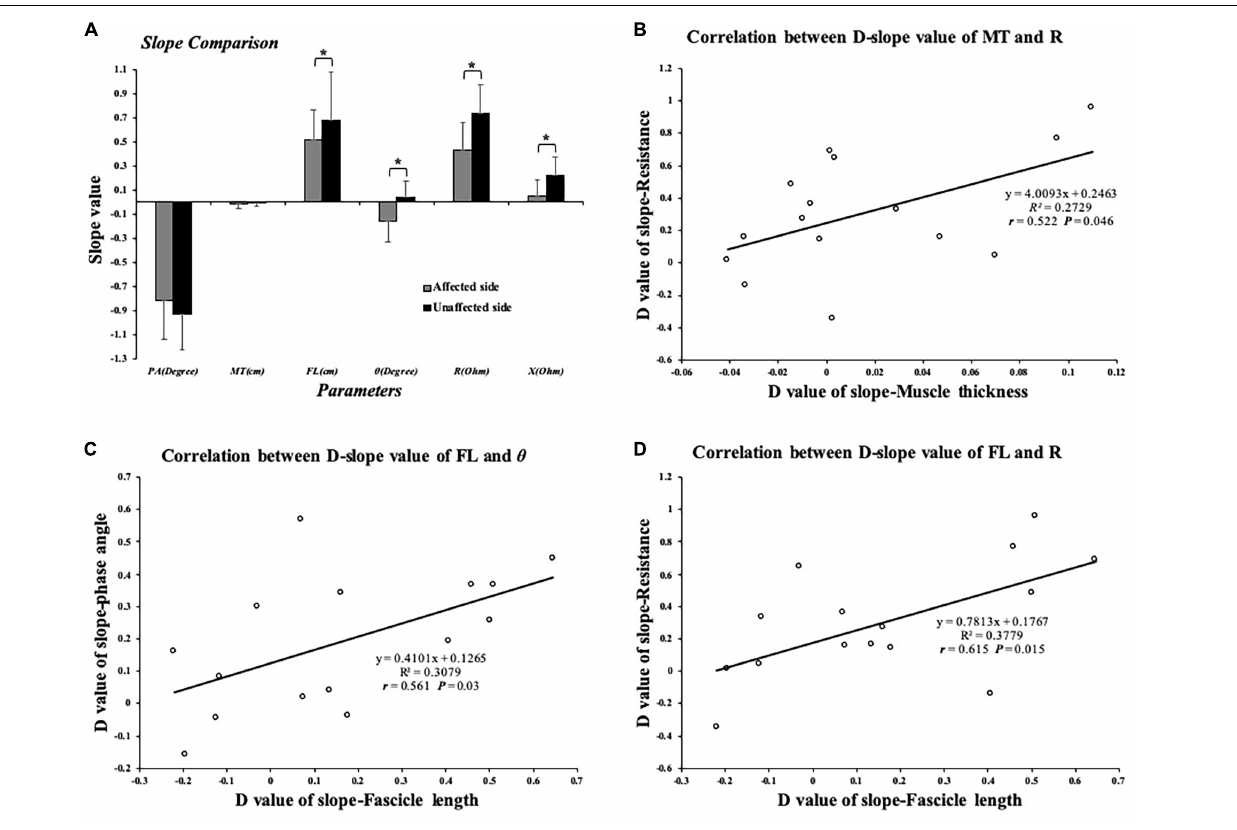
FIGURE 5 | (A) Comparison of slope value of EIM and ultrasound parameters; significant difference was indicated in SFL, SR, SX, and S θ between affected and unaffected sides. (B) Significant correlation between dSMT and dSR values. (C) Significant correlation between dSFL and dS θ . (D) Significant correlation between dSFL and dSR value. ∗ P ≤ 0.05. dSFL, difference value of slope-fascicle length; dSR, difference value of slope-resistance; dSMT, difference value of slope-muscle thickness; dS θ , difference value of slope-phase angle; EIM, electrical impedance myography. Correlation between EIM and ultrasonography parameters.